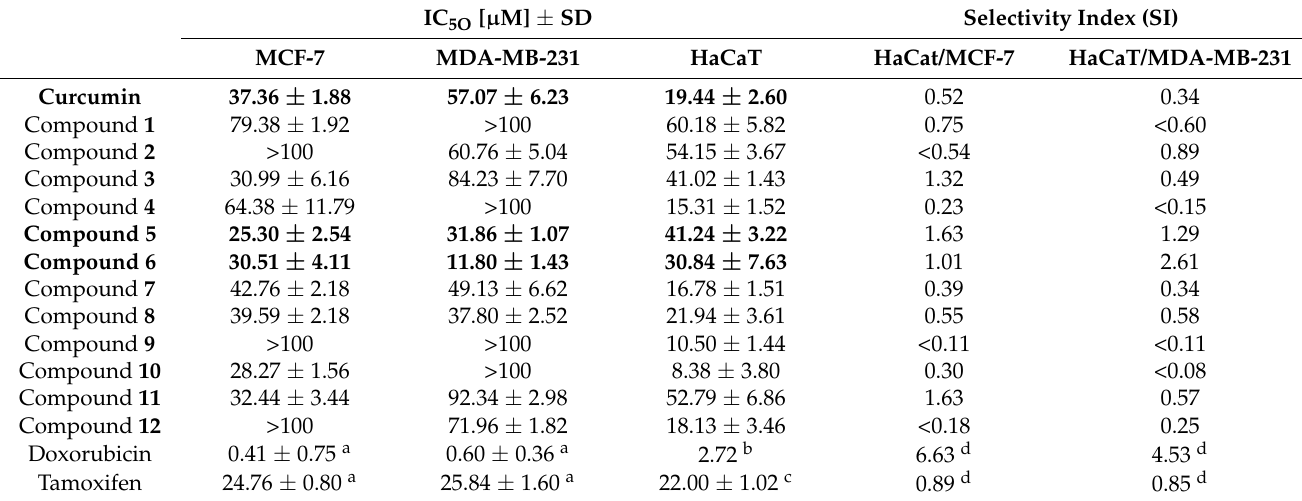
Table 2. IC 50 values against MCF-7, MDA-MB-231, and HaCaT cell lines for curcumin and its new derivatives.